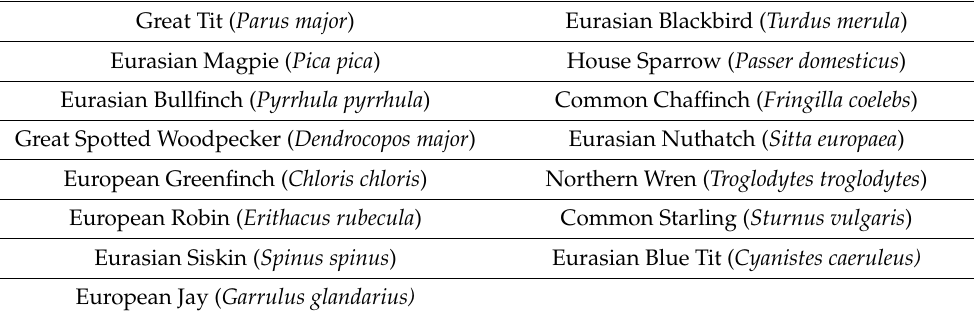
Table 1. List of bird species tested in this study. Great Tit ( Parus major ) Eurasian Blackbird ( Turdus merula ) Eurasian Magpie ( Pica pica ) House Sparrow ( Passer domesticus ) Eurasian Bullfinch ( Pyrrhula pyrrhula ) Common Chaffinch ( Fringilla coelebs ) Great Spotted Woodpecker ( Dendrocopos major ) Eurasian Nuthatch ( Sitta europaea ) European Greenfinch ( Chloris chloris ) European Robin ( Erithacus rubecula ) Common Starling ( Sturnus vulgaris ) Eurasian Siskin ( Spinus spinus